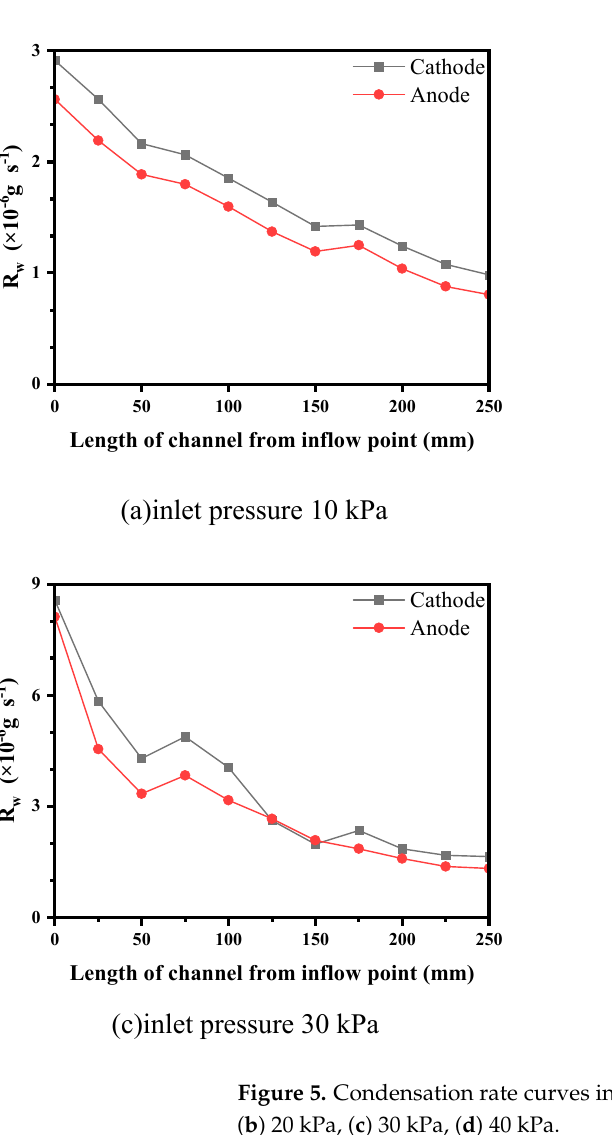
11 of 20 Figure 4. Water content in the anode channel under different inlet pressures: ( a ) 10 kPa, ( b ) 20 kPa,